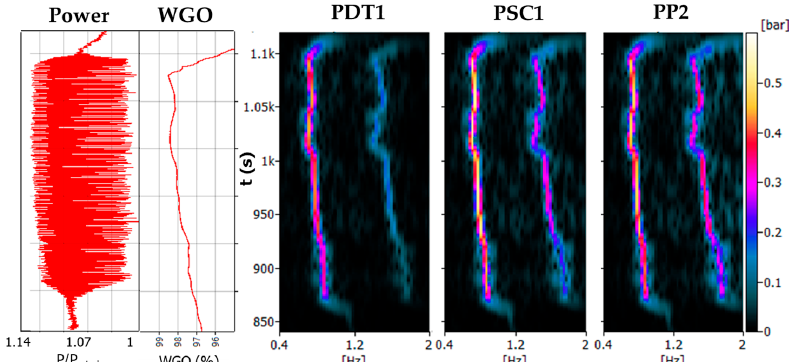
Figure 14. Time-frequency of the pressure in the draft tube (PDT1), in the spiral casing (PSC1) and in the penstock (PP2), as well as the time plot of the power and wicket gate opening (WGO) for the overload instability.